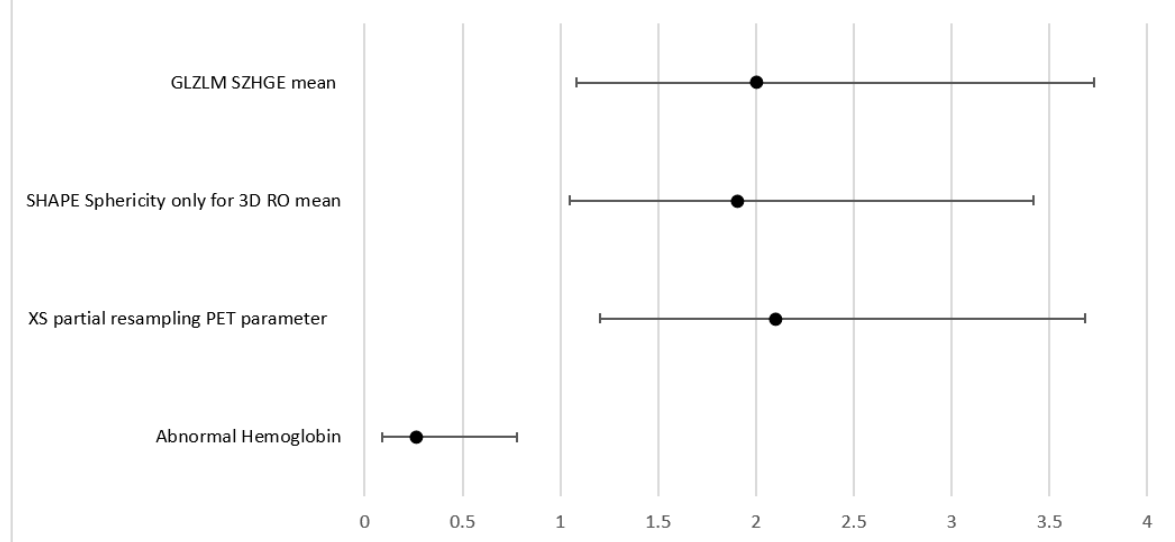
Figure 5. Forrest plot for MVA model when correlating with radiotherapy outcome.